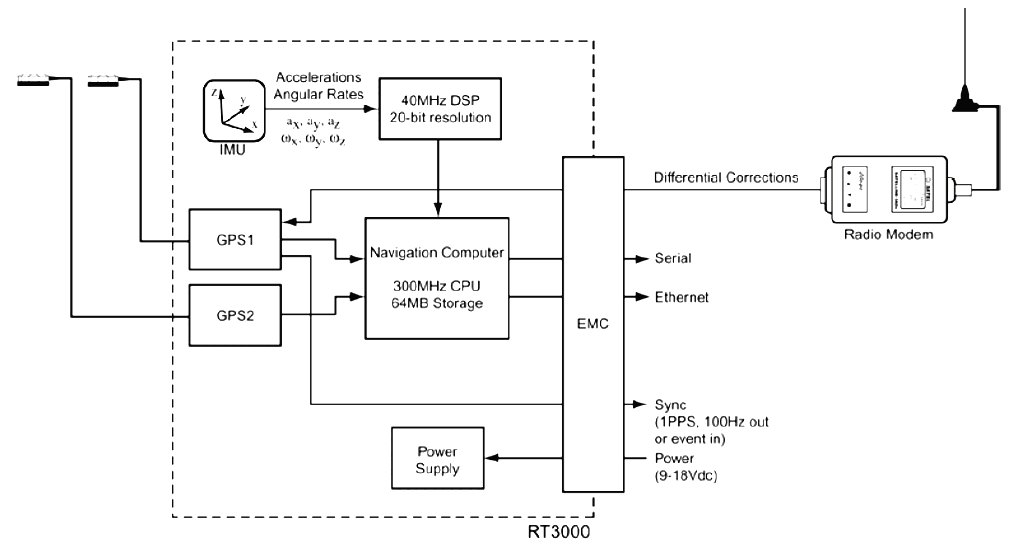
Figure 2. Schematic of the real time RT internal components.